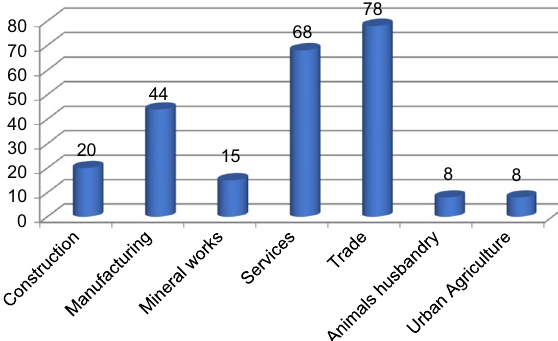
Fig. 2 The types of enterprises by business sectors. Source: field survey,